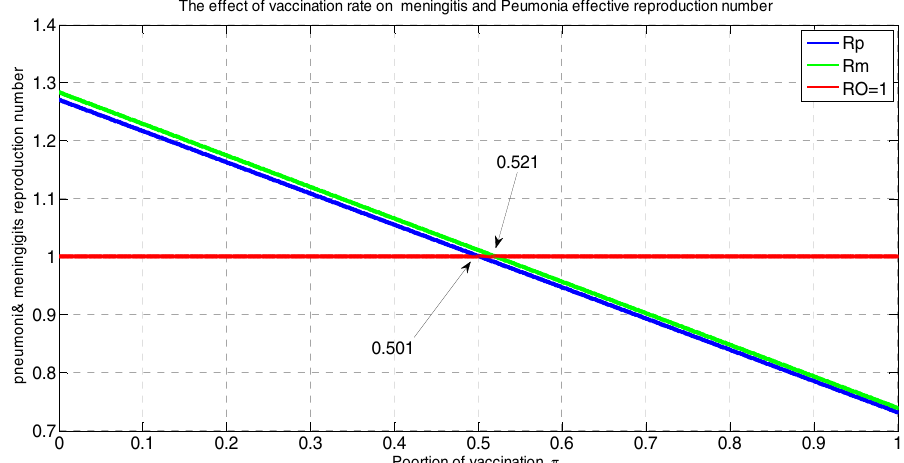
Figure 6. Effect of vaccination on meningitis and pneumonia effective reproduction number.